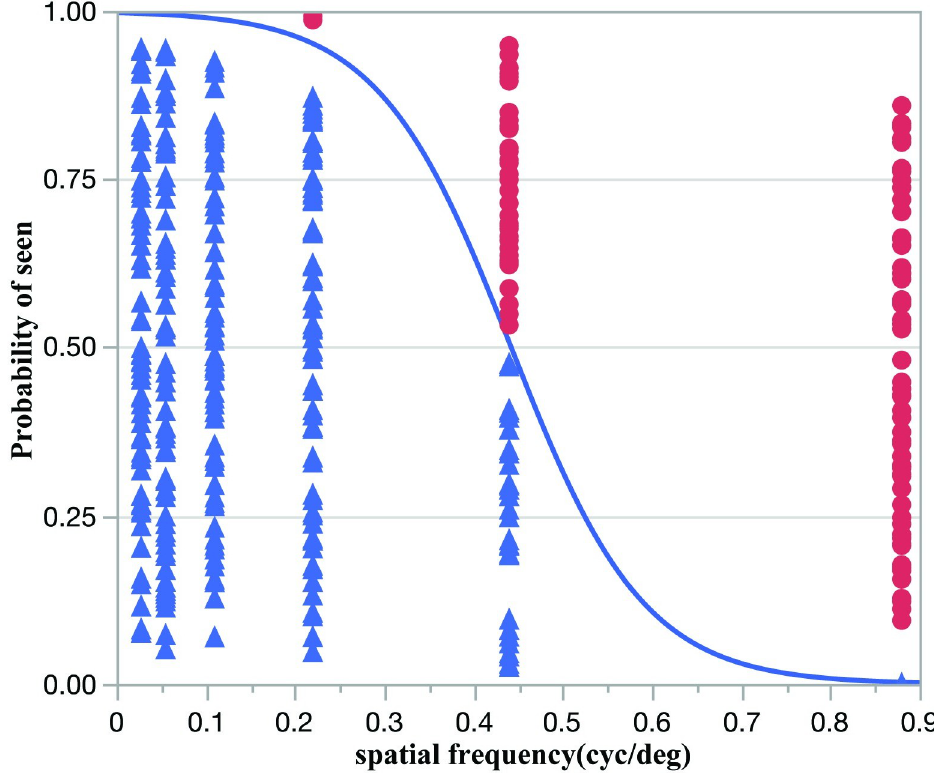
Fig 3. OMR acuity assessed with the nominal logistic fit in C57BL/6J mice. The estimated acuity is the intersection of the logistic curve (blue line) with the 0.50 probability grid line). Data points (blue triangles: SNRs > 1, YES; red circles: SNRs � 1, NO) are jittered along the vertical axis, with no reference to the axis probability scale. Nominal logistic fit of BALB/c mice is not shown as they were unresponsive to the OMR stimulus.